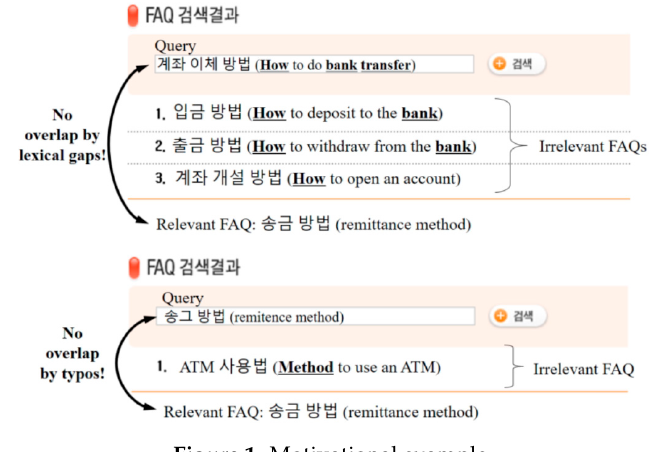
Figure 1. Motivational example.